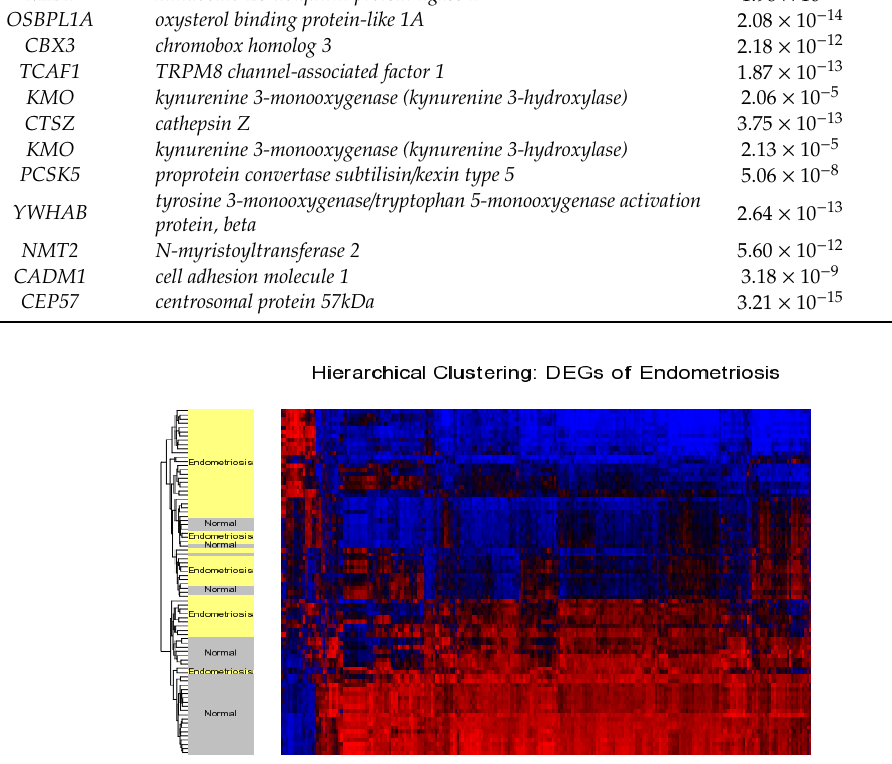
Figure 2. Hierarchical clustering showing distribution of DEGs and cases. Downregulated and upregulated genes are shown in blue and red, respectively, showing a distinct pattern with a majority of genes found to be downregulated in endometriosis.